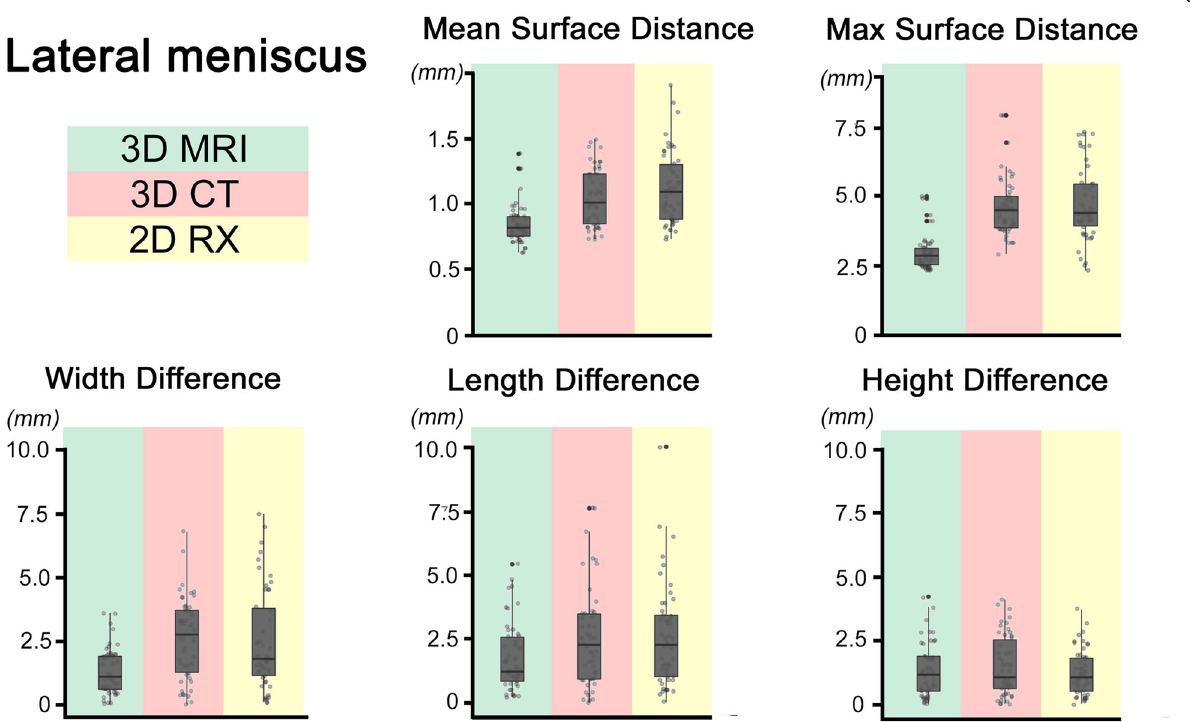
Fig. 6 Lateral Meniscus: Boxplots for lateral meniscus. The box represents the middle 50% of values. The ends of the whiskers indicate 1.5 times the IQR (inter quartile range) between the lower and upper quartile, and outliers are denoted with a